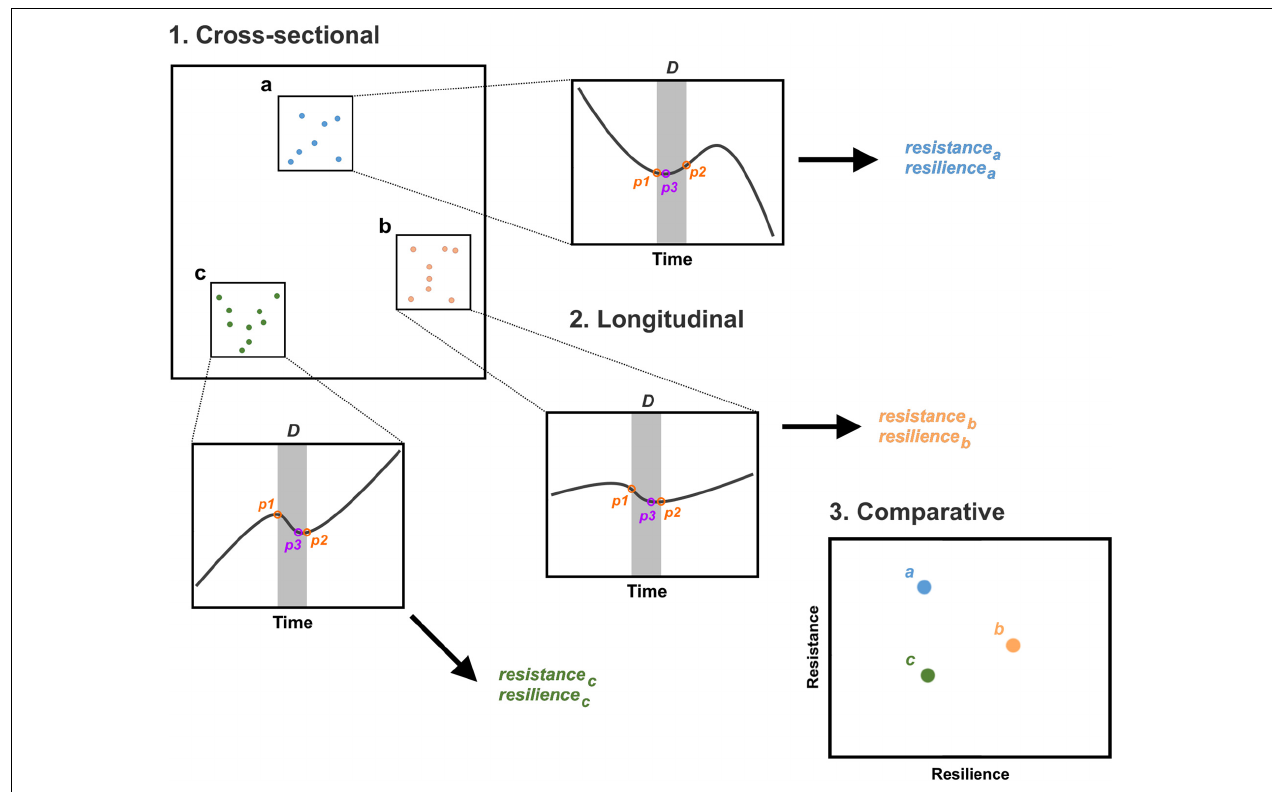
FIGURE 2 | Schematic outline of analytical approach. Cross-sectional data corresponding to the radiocarbon records of different geographical regions are rendered ( via summed probability distributions) into longitudinal data. Measurements before (p1), after (p2), and during (p3) a disturbance D are taken from the palaeodemographic proxy and used to estimate resistance and resilience. Metrics provide an empirical basis for comparing spatiotemporal